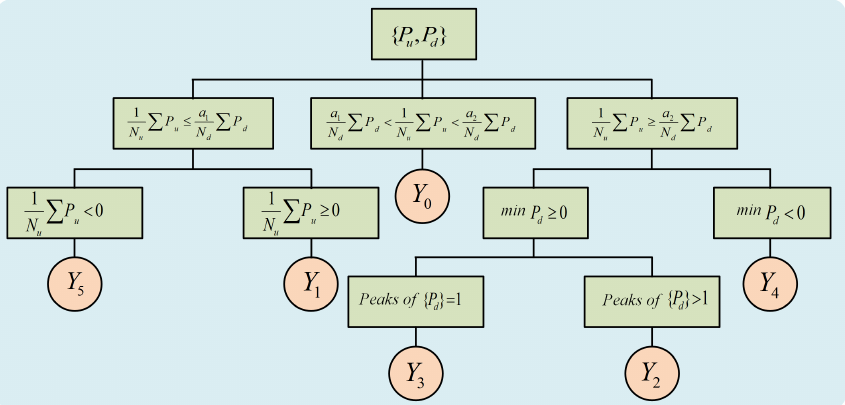
Figure 4. Pseudo-label learning based on the mechanism analysis.